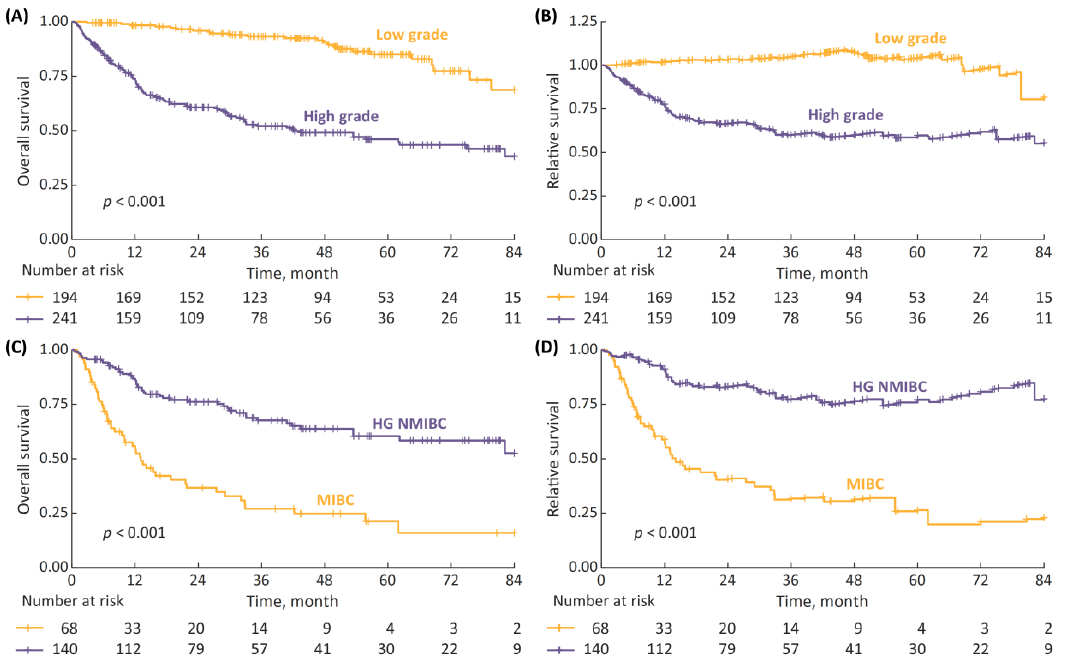
Figure 3. (A) 7-year overall survival (OS) stratified according to cancer grade (low-grade (LG) vs. high-grade (HG)); (B) 7-year relative survival (RS) stratified according to cancer grade; (C) 7-year OS in non-metastatic HG patients stratified according to disease stage (non-muscle-invasive bladder cancer (NMIBC) vs. muscle-invasive-bladder cancer (MIBC)); and (D) 7-year RS according to disease stage.